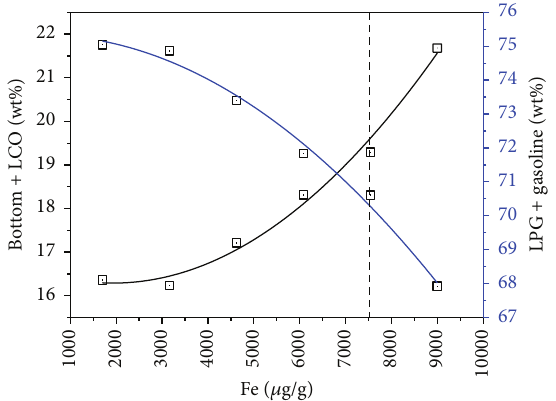
Figure 4: Alteration trend of LPG and gasoline’s yield along with LCO and bottom yield correlated to catalysts’ iron poisoning.